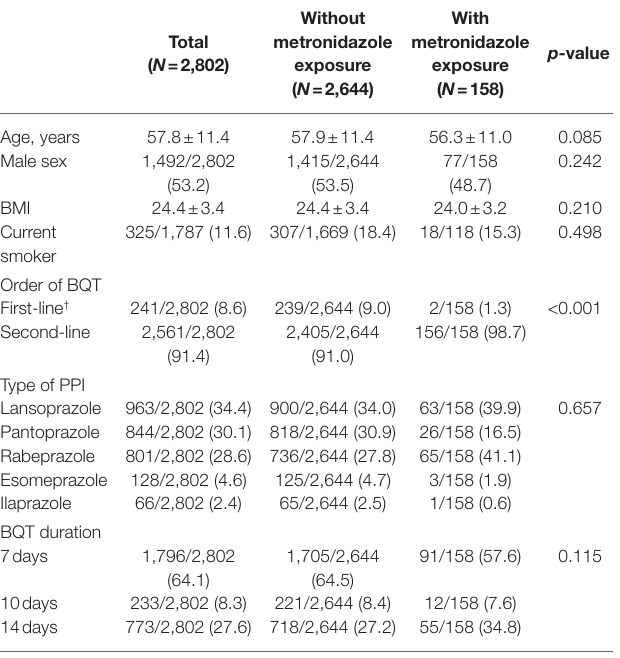
TABLE 1 | Baseline characteristics. TABLE 3 | Past metronidazole exposure duration in people receiving bismuth quadruple